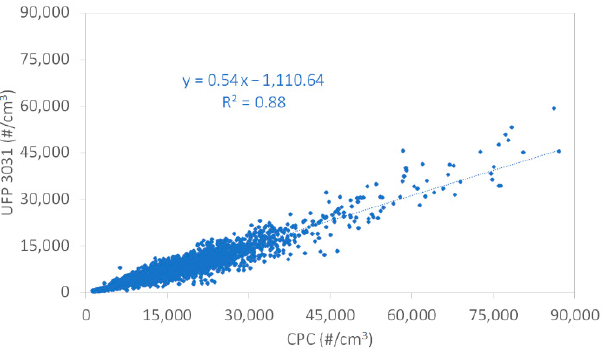
Figure A1. Correlation between condensation particle counter (CPC) and UFP-3031 monitor at roadside site over the campaign.